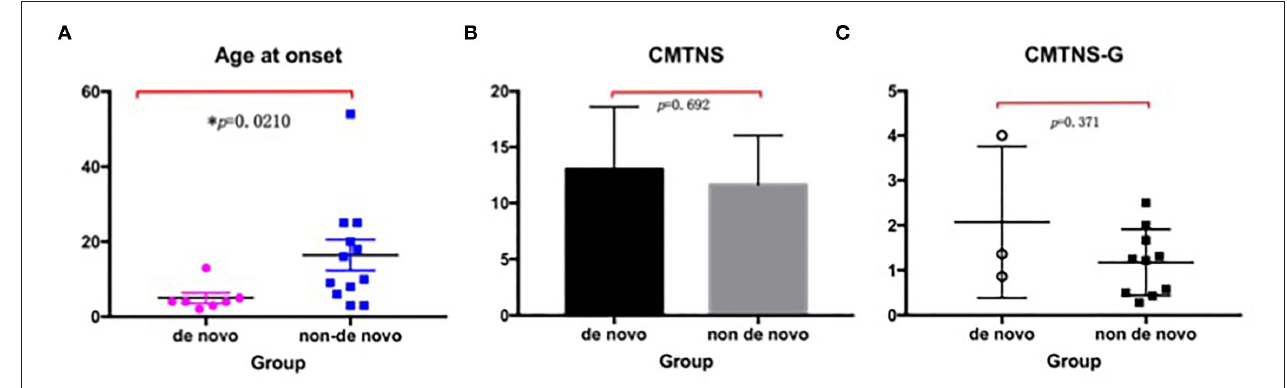
FIGURE 3 | Comparison between the de novo group with the non- de novo group. (A) The median age at onset in the de novo group was significantly lower than that in the non- de novo group ( p = 0.021). (B) The CMTNS showed no significant differences between the two groups ( p = 0.692). (C) The CMTNS-G between the two groups showed no significant differences ( p = 0371). CMTNS, Charcot–Marie–Tooth disease neuropathy scores; CMTNS-G, Charcot–Marie–Tooth disease neuropathy scores